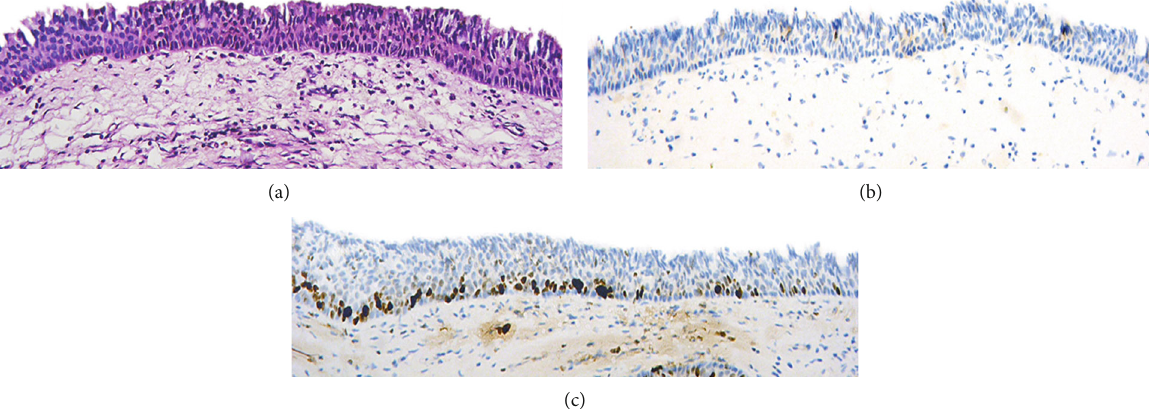
Figure 1: Normal respiratory epithelium: (a) by H&E (H&E × 200); (b) by IMP3 showing low intensity of cytoplasmic staining in scant epithelial cells (IHC × 200); (c) by Ki-67 showing low to moderate nuclear expression in nuclei of epithelial cells (IHC × 200).